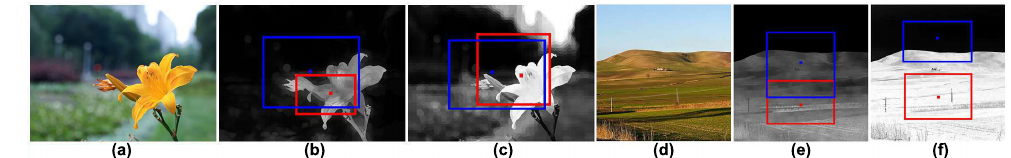
Figure 8. Examples of rectangles representing the distribution of pixel values. ( a , d ) original images, ( b , e ) sharpness maps, ( c , f ) color saliency maps. Red rectangles represent the distributions of pixel values in those images while blue rectangles reflect the distributions for the corresponding video inverted